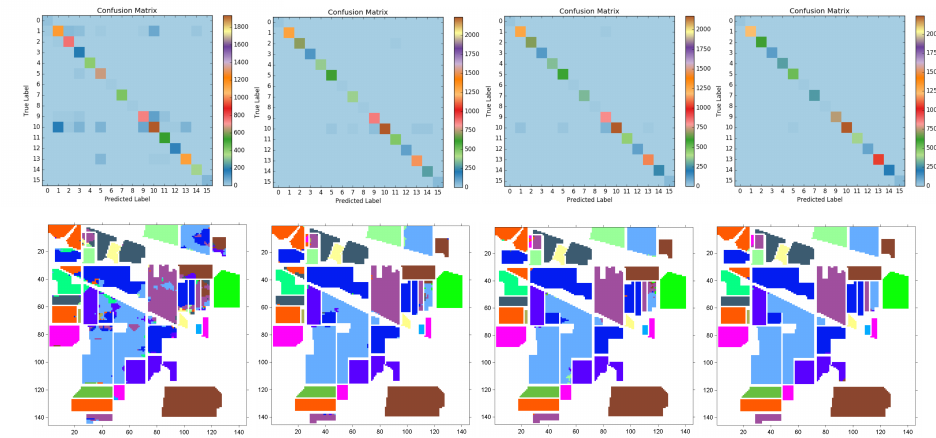
Figure 13. Classification results for the IP image with d = 19 and number of samples per category = 50 (first column), 100 (second column), 150 (third column), and 200 (fourth column). The upper row represents the visualization results of the confusion matrix for each category on the testing set (the more prominent the color of the diagonal area, the better the result) and the lower row represents the qualitative results of classification